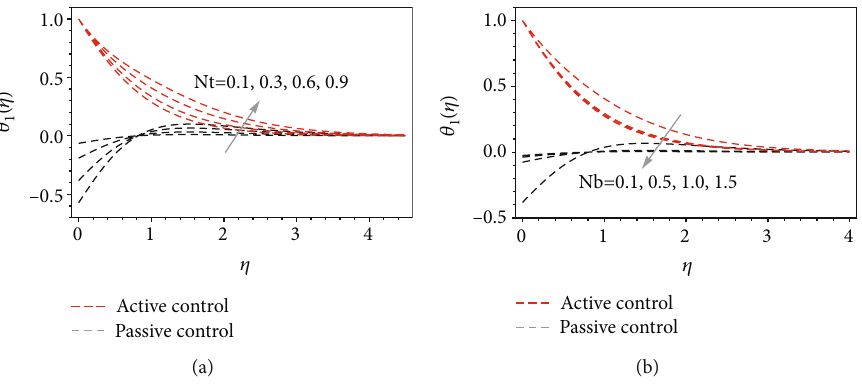
Figure 5: Nanoparticle concentration pro fi le for various values of Nt andNb :